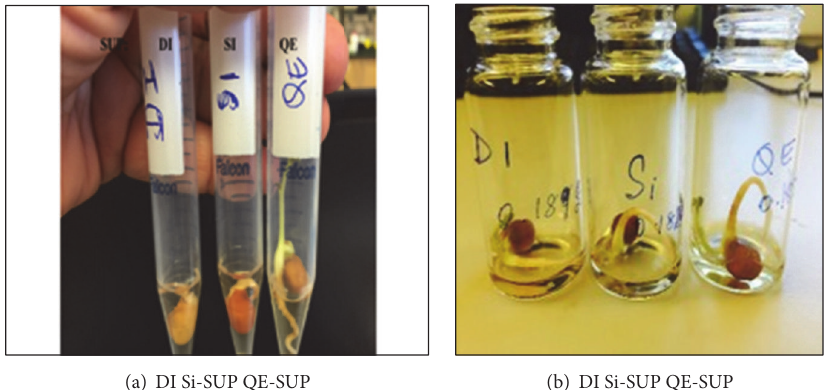
Figure 11: Representative images of early germination and growth observed in chickpea seeds immersed in equal volumes of DI water, Si-SUP, or QE-SUP in (a) test tubes or (b) liquid scintillation vials.